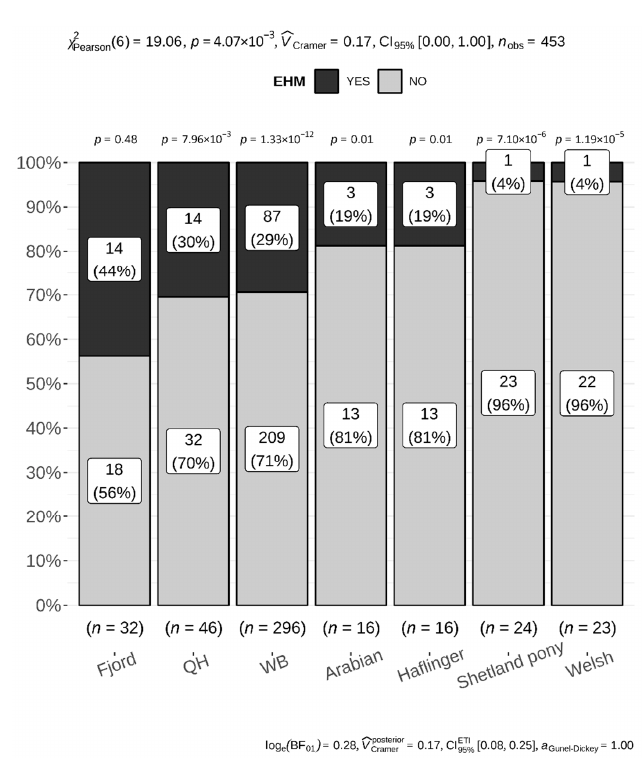
Figure 1. From left to right, 7 distinct breeds (Fjord, Quarter Horse (QH), Warmblood (WB), Arabian, Haflinger, Shetland and Welsh pony) are arranged by decreasing EHM frequency (numbers and percentage as stacked bar plot). The p -values above individual stacked bars compare the proportions of EHM-affected (dark gray) individuals to unaffected (light gray) animals within each breed. A chi-square test (top of the plot) finds a significant relationship between breed and EHM ( p = 0.004), suggesting the need of post hoc pairwise comparisons between individual breeds via Fisher’s tests (reason: low numbers per category). The effect of this relationship is small (V Cramer = 0.17 [21]). In contrast to the p -value, the Bayes Factor (BF) provides weak evidence for a relationship between EHM and breed (log(BF01) = 0.28 [22]), whereas the Bayesian effect size suggests a moderately strong relationship (V Cramer = 0.21; 95% Highest Density Intervals 0.22; 0.73). Such disagreement between the frequentist (plot top) and Bayesian methods (plot bottom) might be caused by a low number of observations in several breeds and suggests the need for more